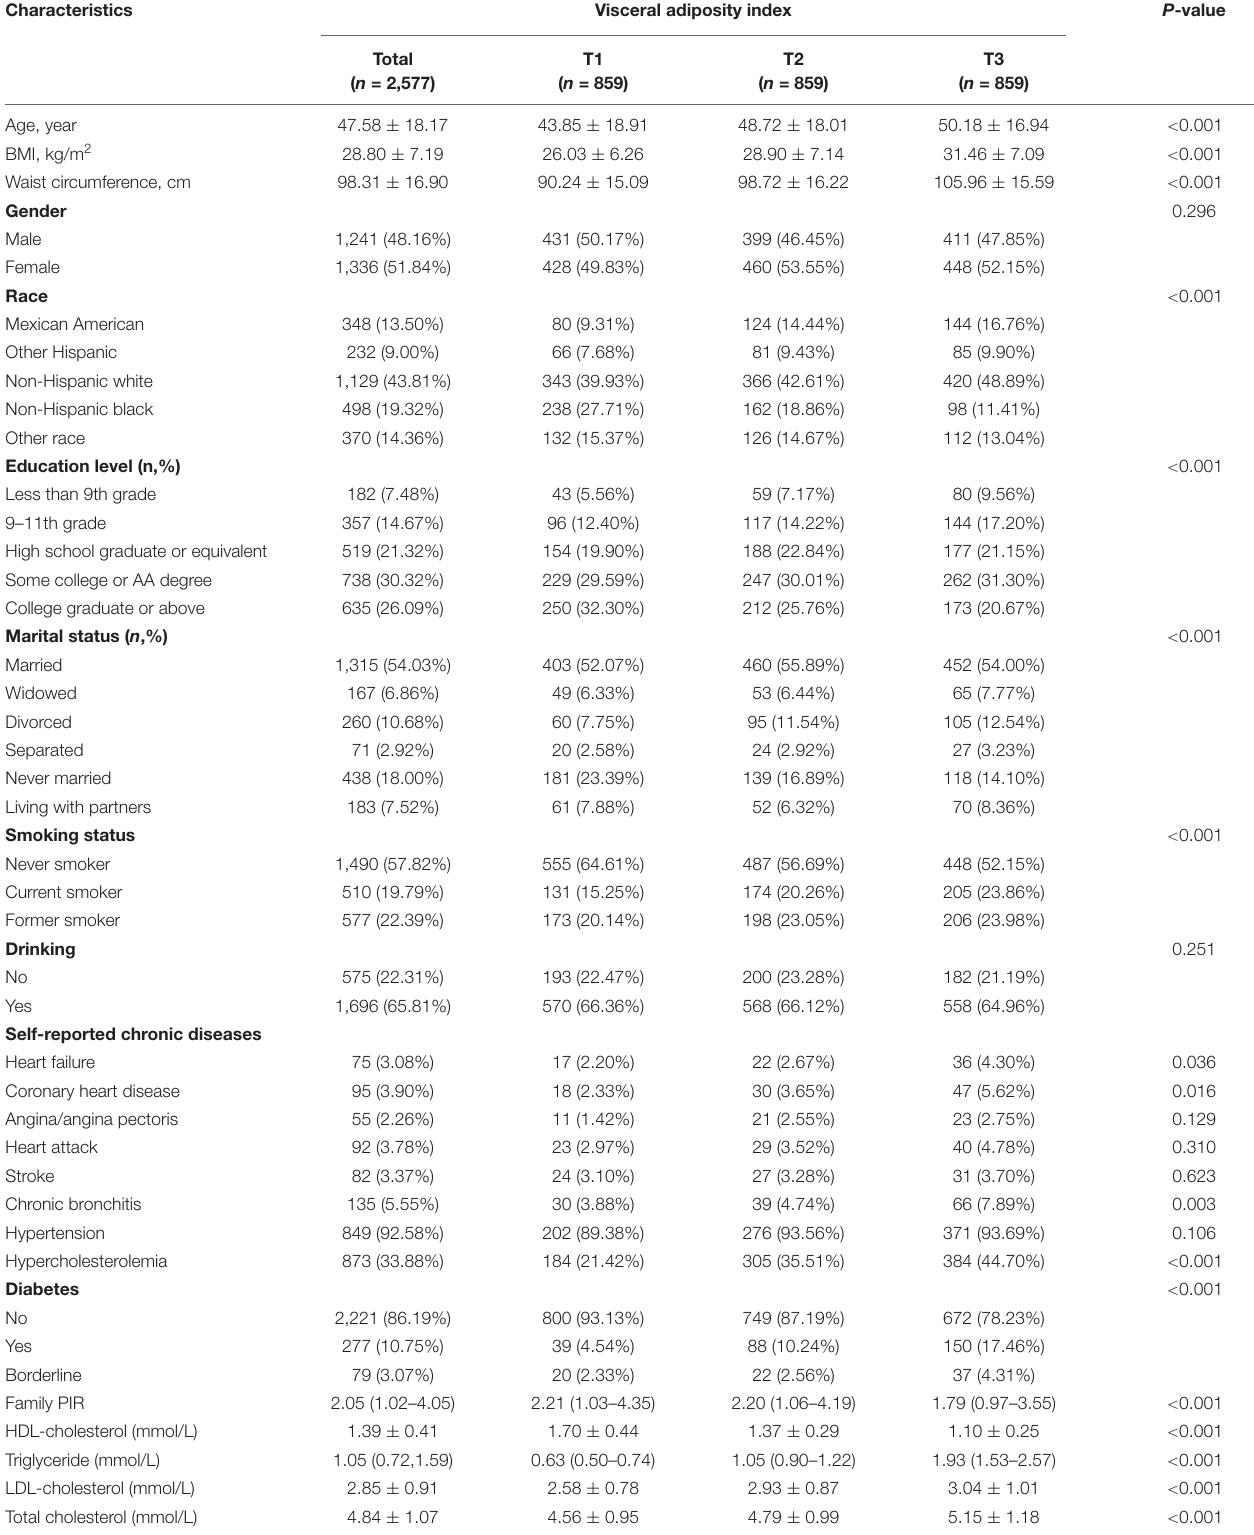
TABLE 1 | Baseline characteristics of the cohort ( N = 2,577).